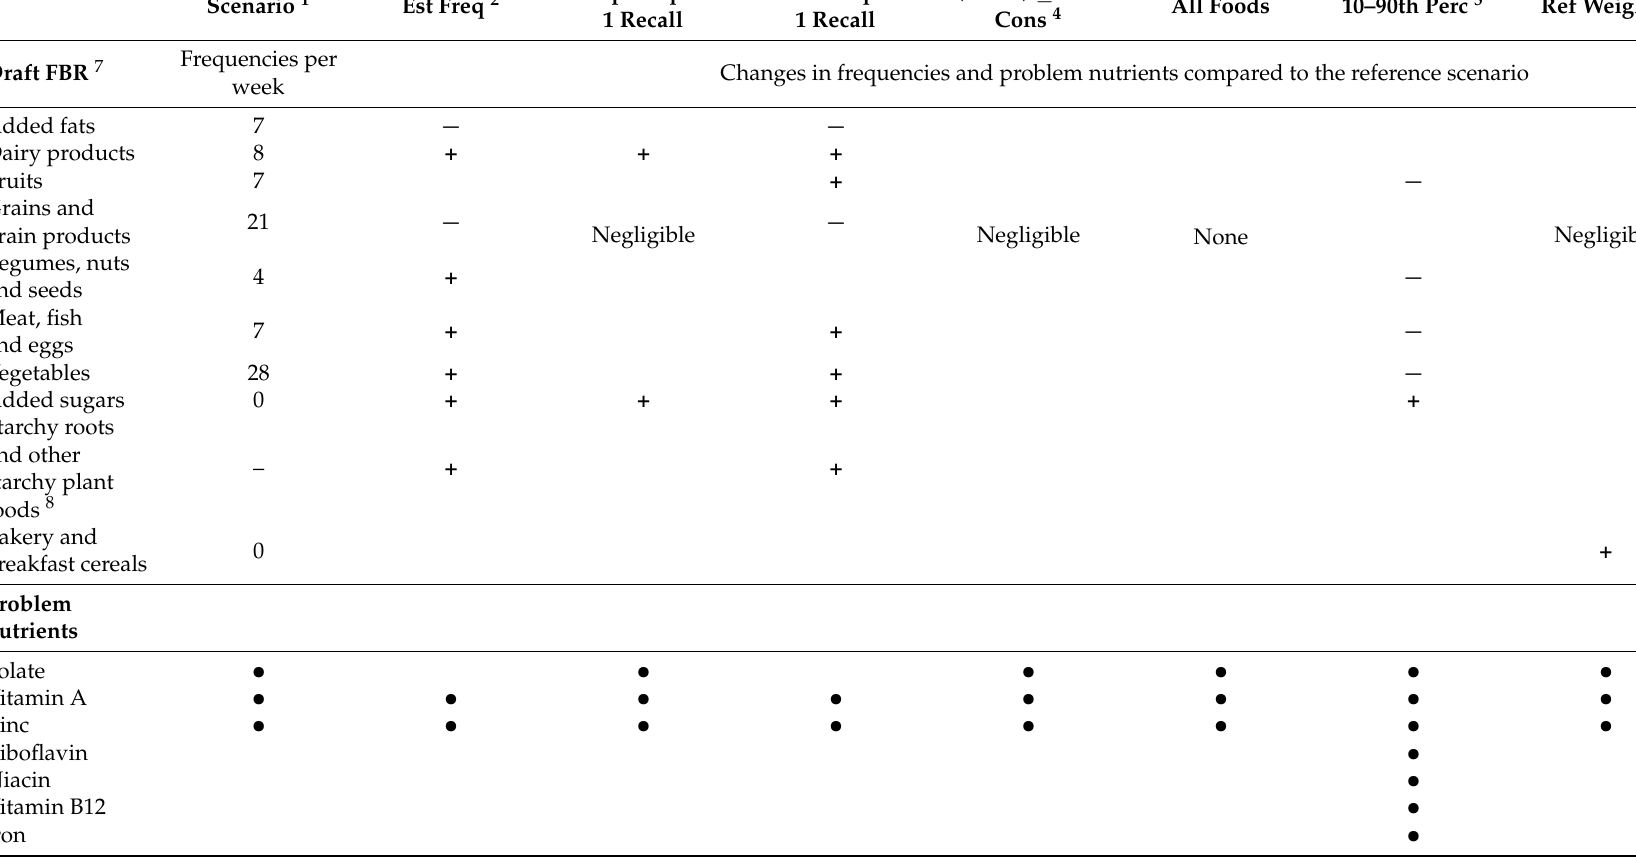
Table S2 for more details on classification of foods. 8 –: not included in the